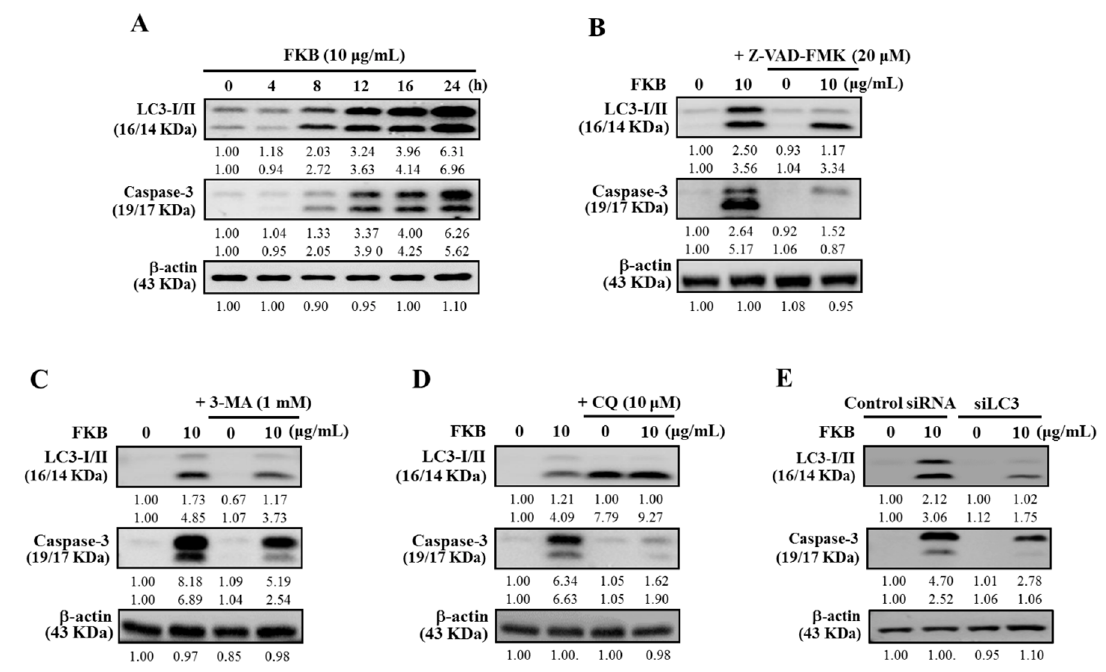
Figure 11. Inhibition of either apoptosis or autophagy compromised occurrence of FKB-induced cell death in A375 cells. ( A ) Western blot showing the effect of time on the expression patterns of LC3-I/II and caspase-3 with response to FKB (10 µg/mL) for 0–24 h. ( B – D ) Western blot showing the expression of LC3-I/II and caspase-3 levels in different conditions. ( B ) Cells were pretreated with caspase inhibitor (Z-VAD-FMK, 20 µM) and ( C , D ) early or late autophagy inhibitors (3-MA, 1 mM and CQ, 10 µM) for 1 h followed by FKB (10 µg/mL) for 24 h. ( E ) Control small interfering RNA (siRNA) and LC3 knockdown cells (siLC3) were treated with FKB (10 µg/mL) for 24 h, followed by the measurement of the expressions of LC3-I/II and caspase-3 proteins through the Western blot. β - actin was used as an internal control. Results are expressed as the mean ± standard deviation (SD) of three experiments.